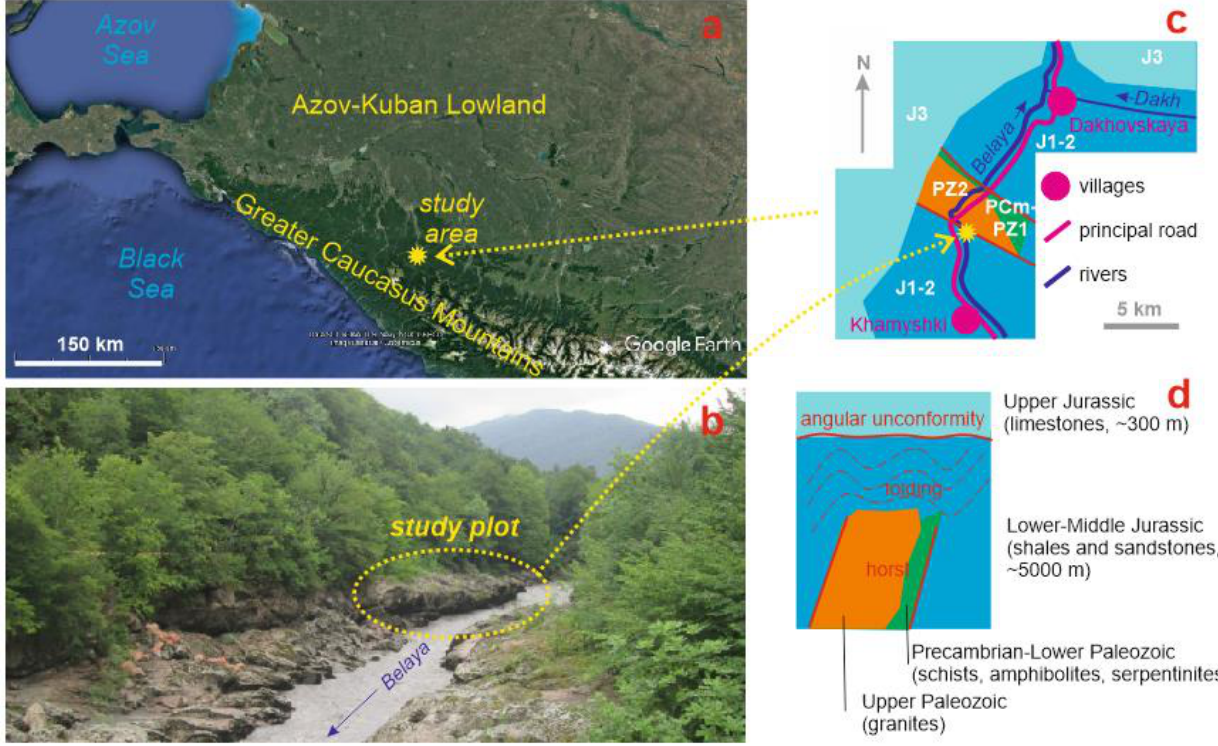
Figure 1. Location of the study area: ( a ) general geographical setting (the satellite image is obtained with “Google Earth Engine”), ( b ) view of the study plot, ( c ) local geology shown schematically on the basis of the personal author’s observations (PCm-PZ1—Precambrian–Lower Paleozoic; PZ2—Upper Paleozoic; J1-2—Lower–Middle Jurassic; J3—Upper Jurassic), ( d ) simplified geological cross-section.